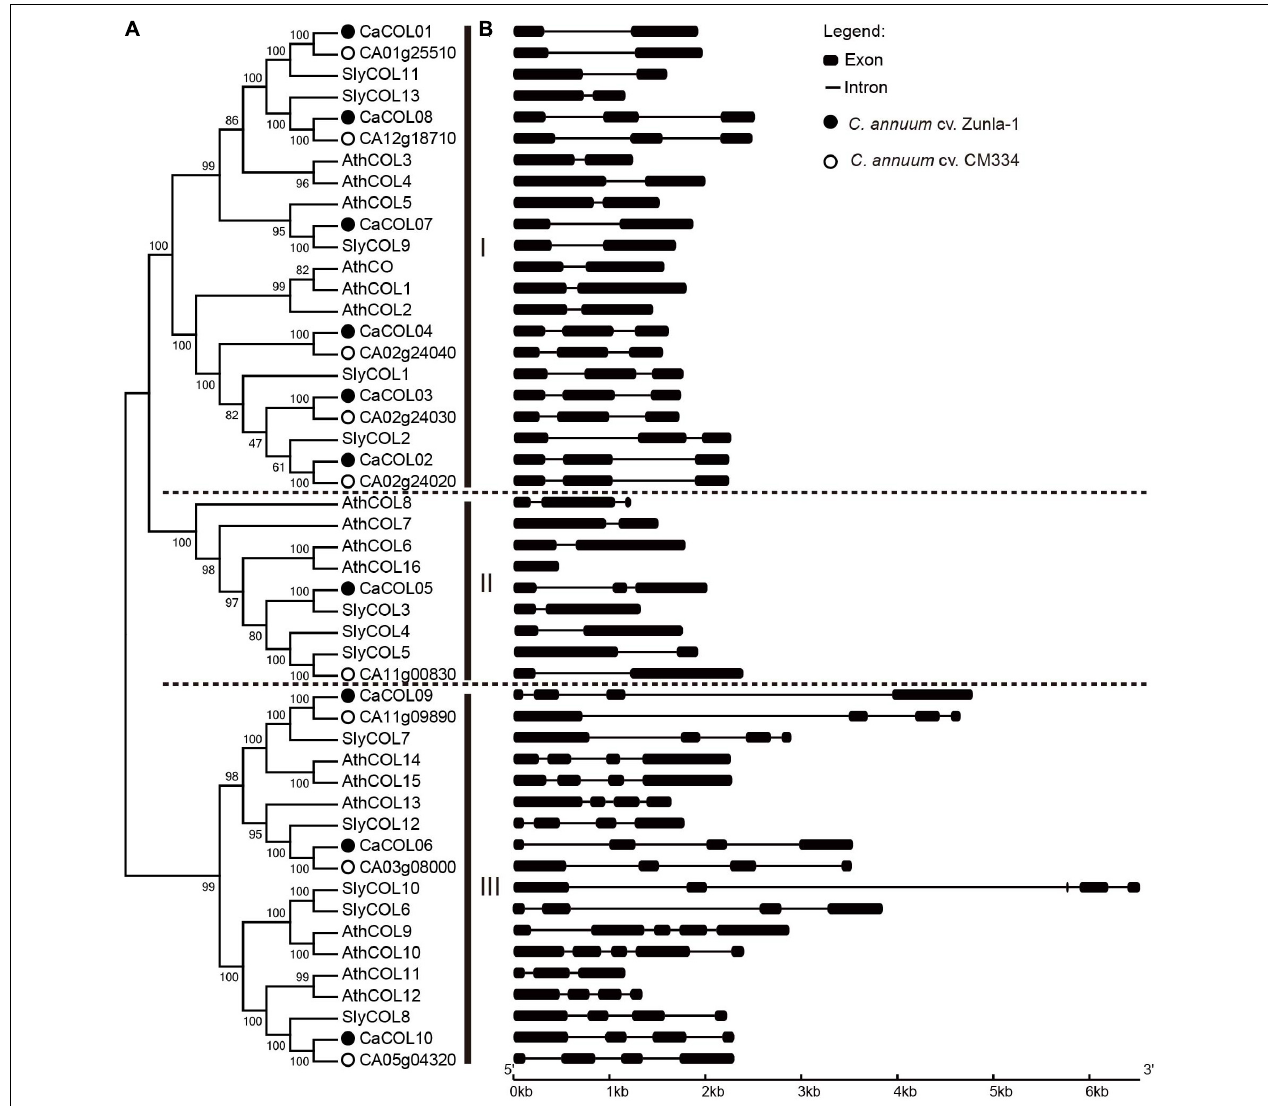
FIGURE 1 | Phylogenetic analysis (A) and gene structures (B) of COL homologs in Capsicum annuum , Solanum lycopersicum , and Arabidopsis thaliana. The phylogenetic relationship of COLs categorized them into three groups (I, II, and III). COLs of C. annuum Zunla-1 and CM334 are indicated by black balls and hollow circles, respectively. Exons and introns are represented by black boxes and black lines,